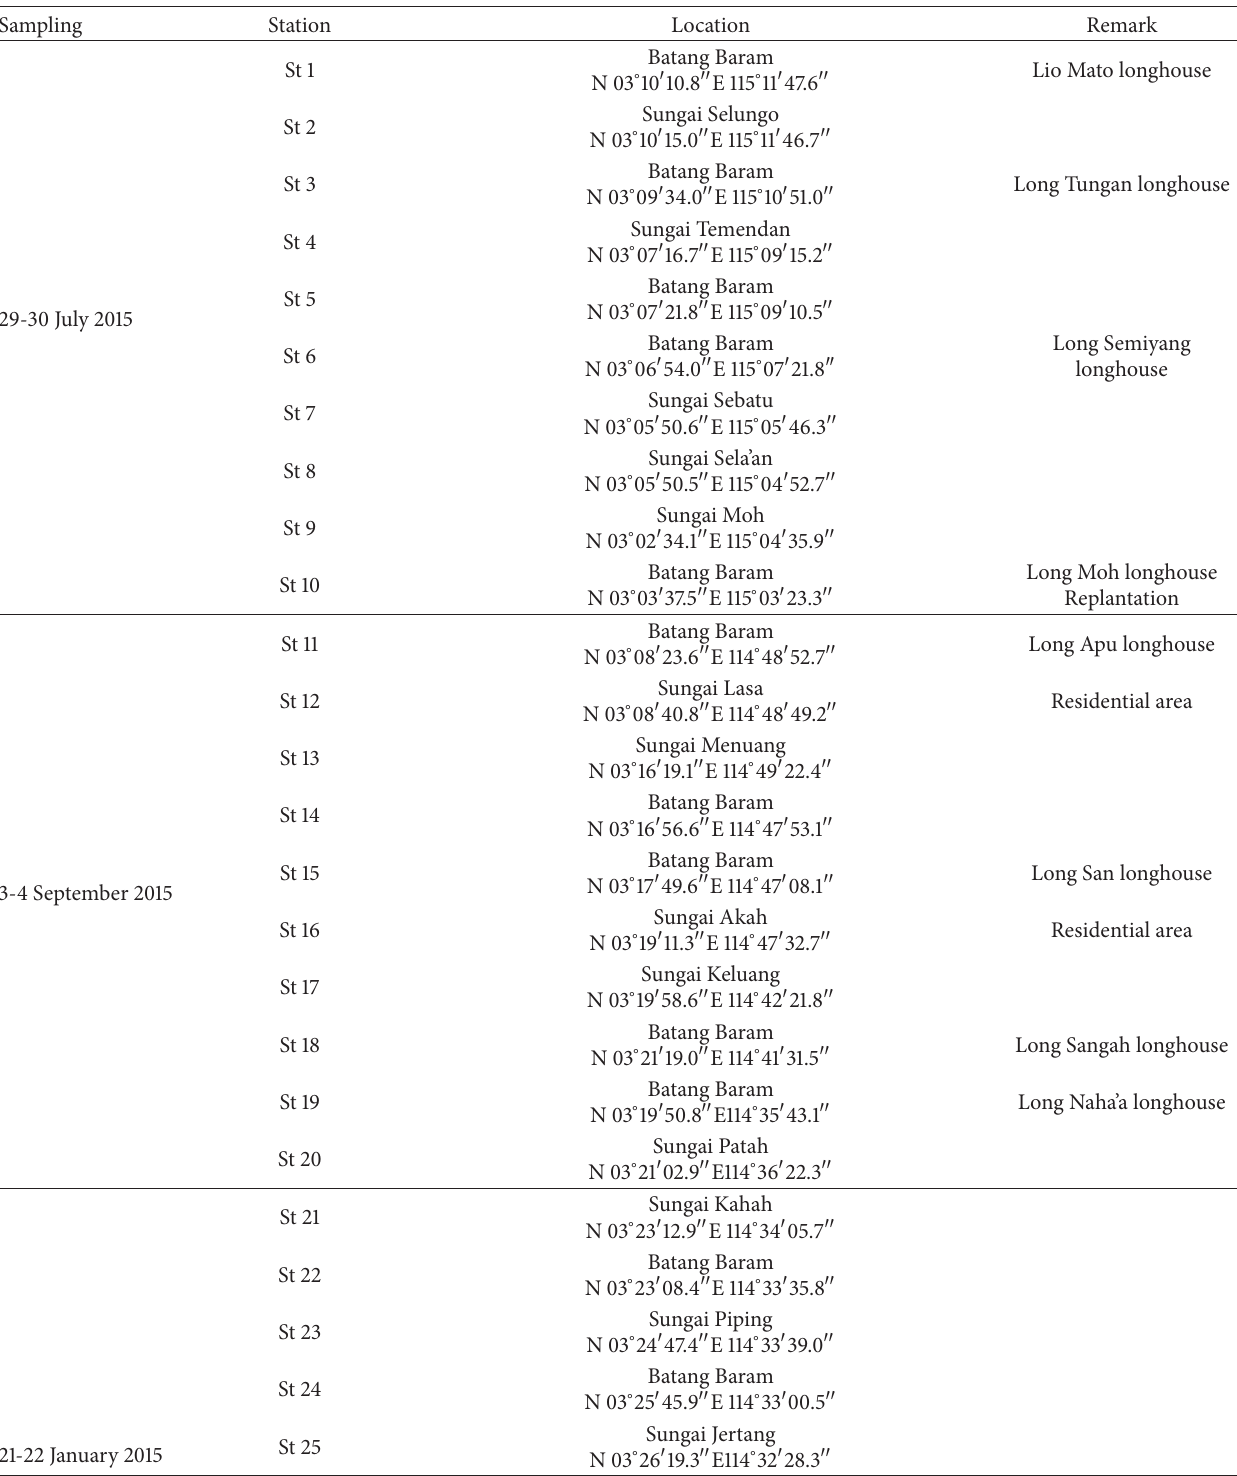
Table 1: The details of the sampling regime and sampling locations surveyed in the present